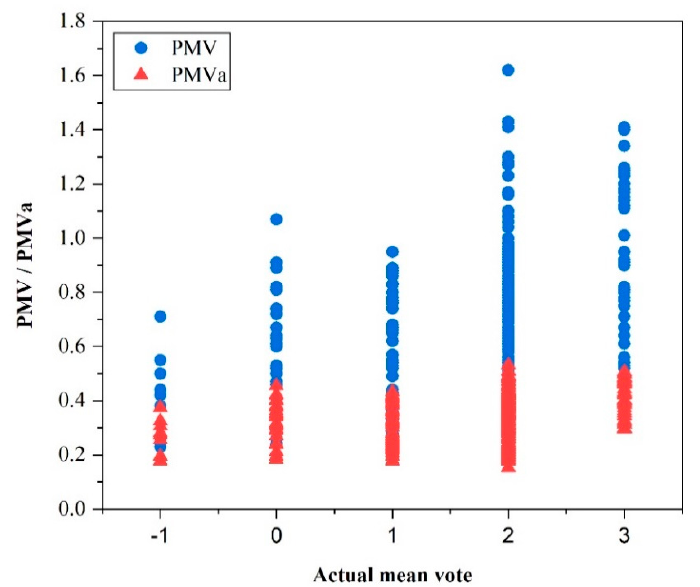
Figure 17. Comparison between adaptive predicted mean vote (PMVa) and PMV as a function of AMV.